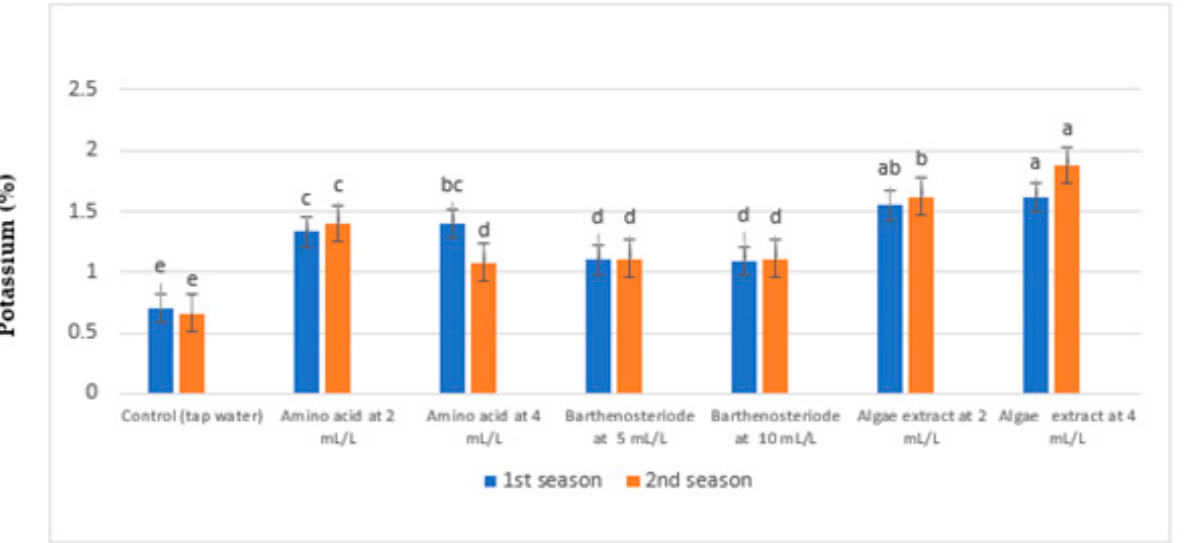
Figure 3. Effect of various bio-stimulant treatments on potassium (%) of chia (Salvia hispanica L.) plants during the 2019–2020 and 2020–2021 seasons. For the same column, means followed by the same letter are not statistically different, according to the Tukey multiple range test.